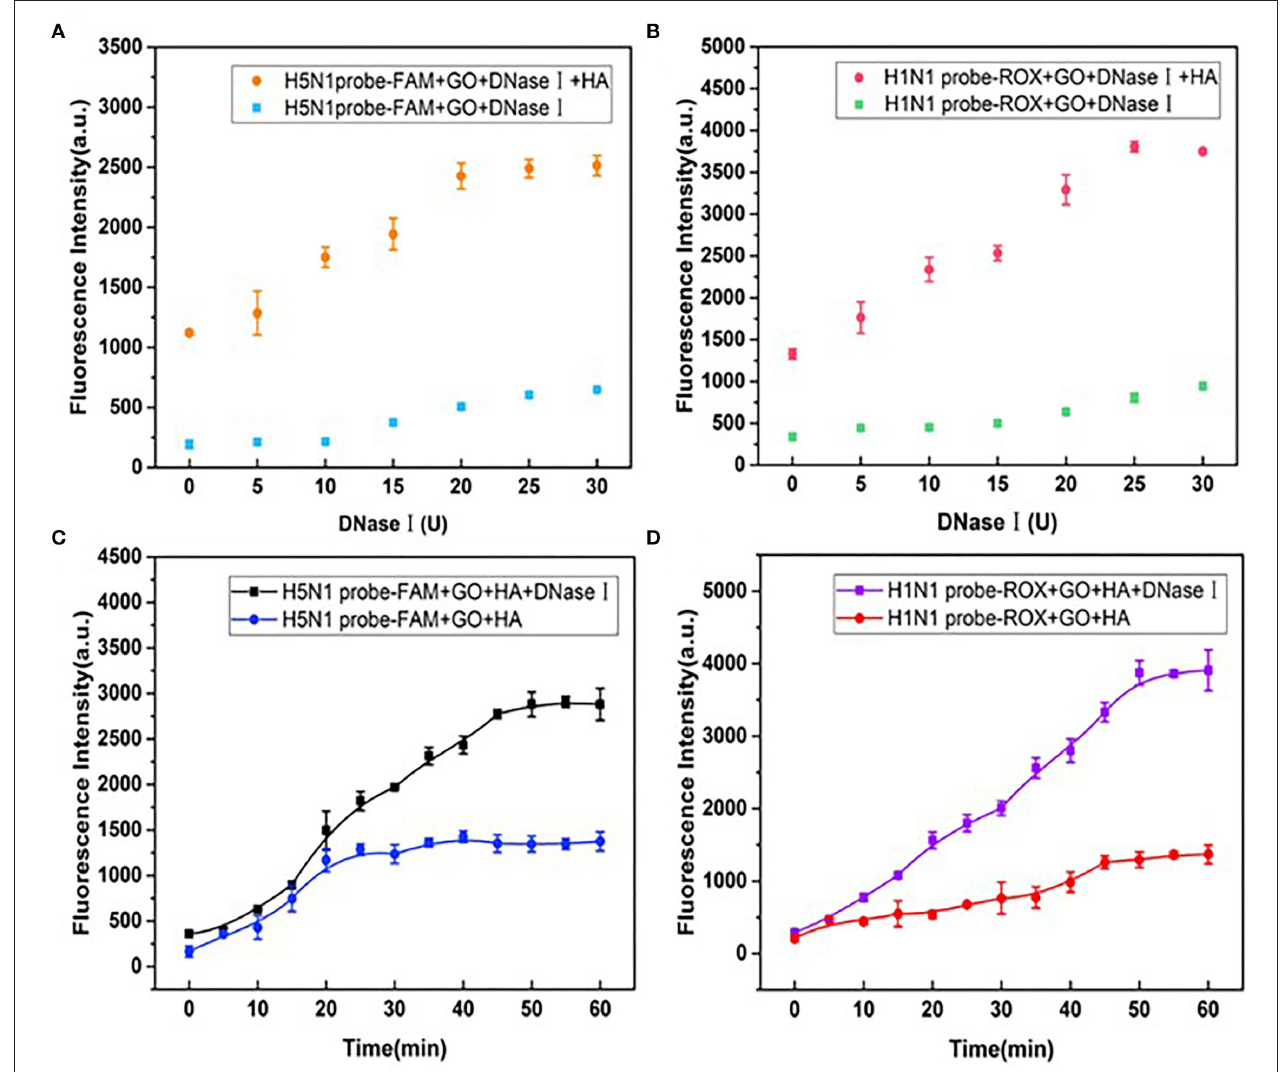
FIGURE 6 | Effects of different doses of DNase I on fluorescence recovery for (A) H5N1-FAM and (B) H1N1-ROX probes in the detection system. Effects of incubation times of DNase I on fluorescence recovery for (C) H5N1-FAM and (D) H1N1-ROX